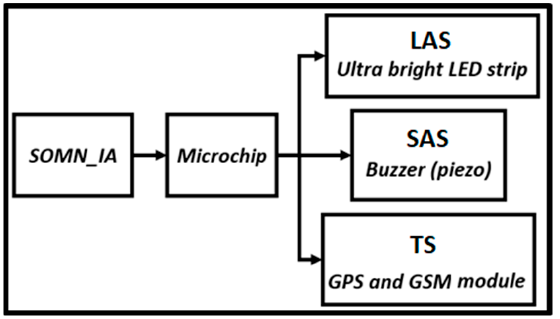
Figure 15. LAS, SAS, and TS connection and activation process.